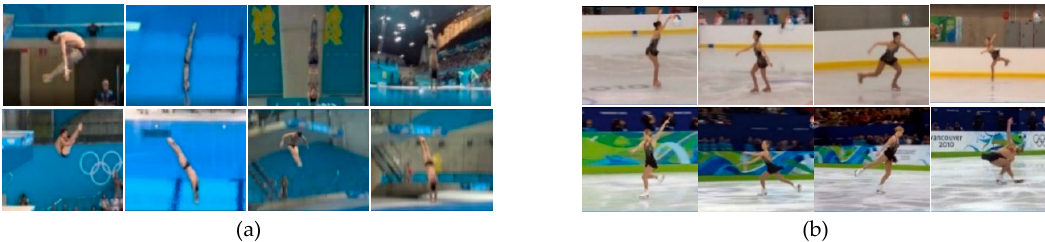
Figure 6. Example frames of the MIT Olympic Scoring dataset [26]. (a) Example frames of diving. (b) Example frames of figure skating.